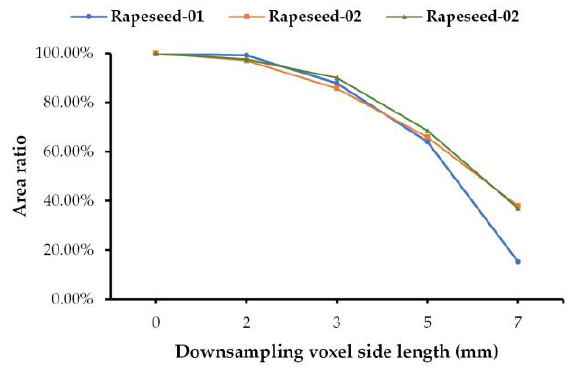
Figure 12. Line chart of the relationship between voxel grid size and LA